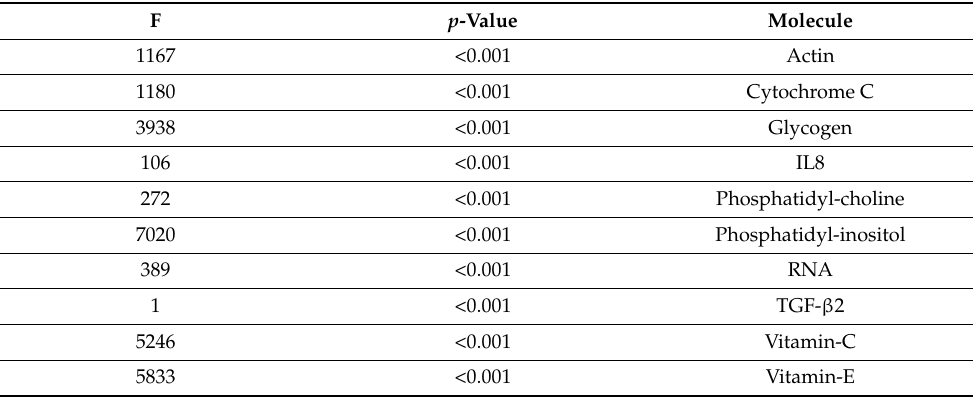
Table 3. Results of testing via Welch’s ANOVA on CLS coefficients from fitting of LNCaP cell spectra.